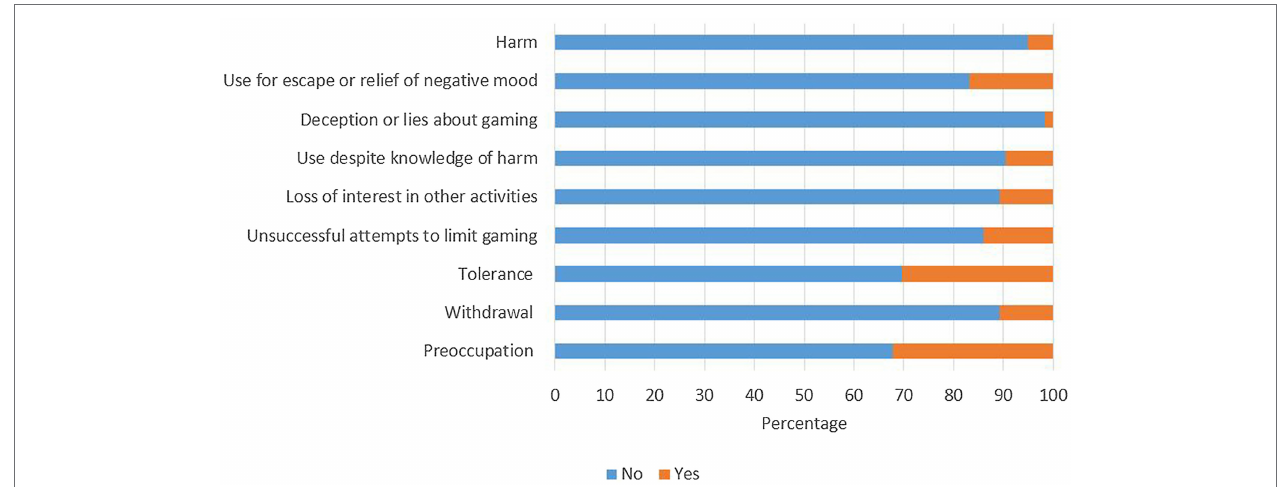
FIGURE 4 | Endorsement rate of each item of Internet gaming disorder scale among Internet gamers ( n = 177).